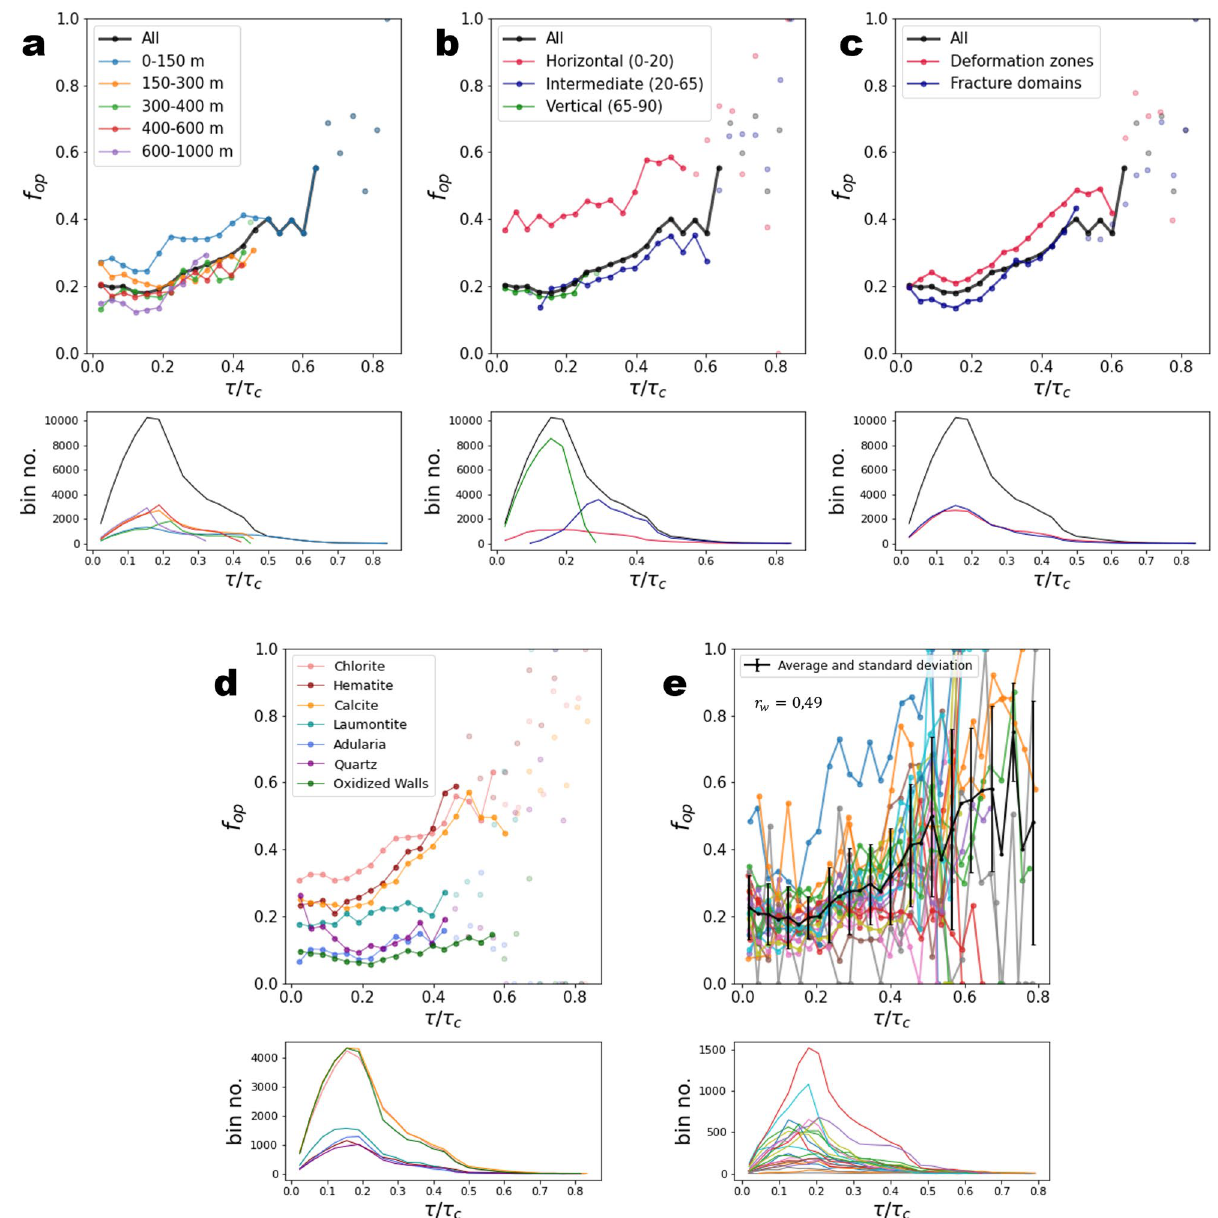
Figure 3. Openness f op as a function of the ratio τ/τ c . The critical shear stress τ c is calculated as τ c = µ . σ n + c , with c = 4 MPa and µ = 1.33 , cohesion and friction coefficients of sealed fractures. The results are presented as a function of ( a ) depth range, ( b ) dip range, ( c ) structural domains, ( d ) filling minerals, and ( e ) by borehole. Transparent dots correspond to bins with fewer than 100 fractures. Lower subplots indicate the number of fractures in each bin. In each plot, bin size is 0.033 MPa. In ( e ), we calculated the Pearson correlation coefficient, weighted by the fracture number in each bin, r w (e.g., low-permeability cap rock 41 or disconnected fracture clusters) or transient (e.g., permeability decrease by fracture healing 23,44 ), or a source of overpressure (e.g., ice cap 27,45–47 ), or dehydration reactions 48 ).